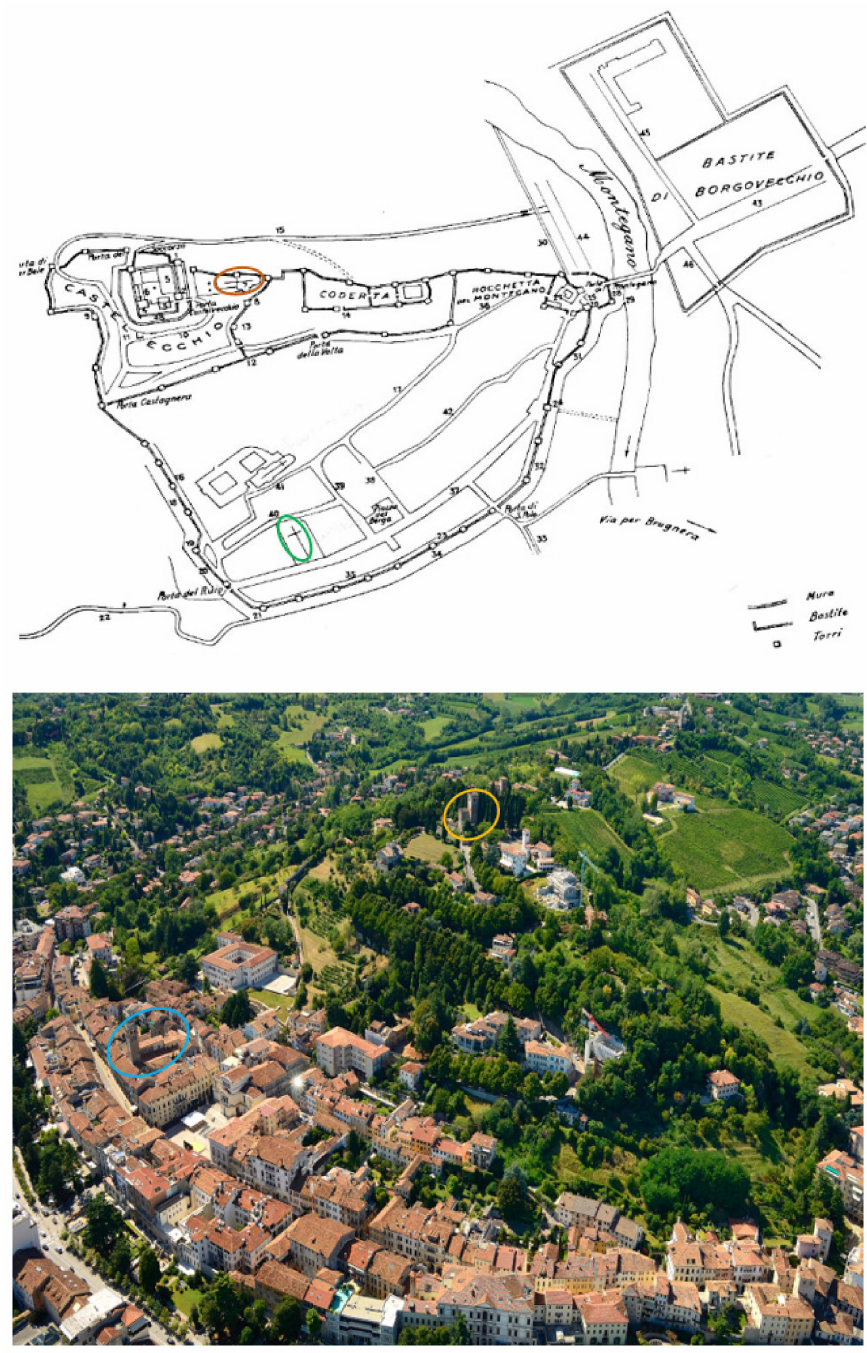
Figure 8. Top: an old masterplan of the city of Conegliano in the XV century, [39]. Brown circle: an old church very close to the castle. Green circle: the Dome of Conegliano. Bottom: a contemporary sky view of the City of Conegliano. On the top of the hill, the castle is clearly visible (yellow circle). Down left, the Dome of Conegliano, with its bell tower (cyan